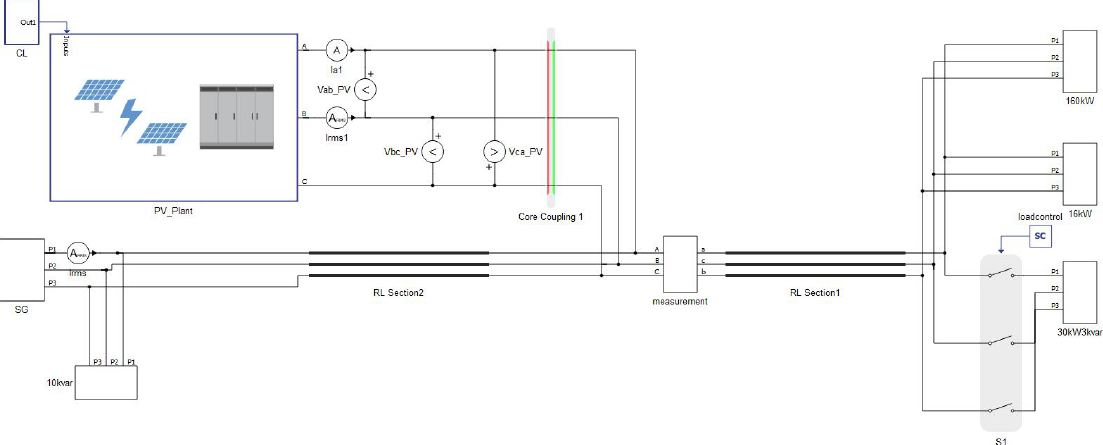
Figure 3. Real-time simulation (RTS) model of micro-grid under